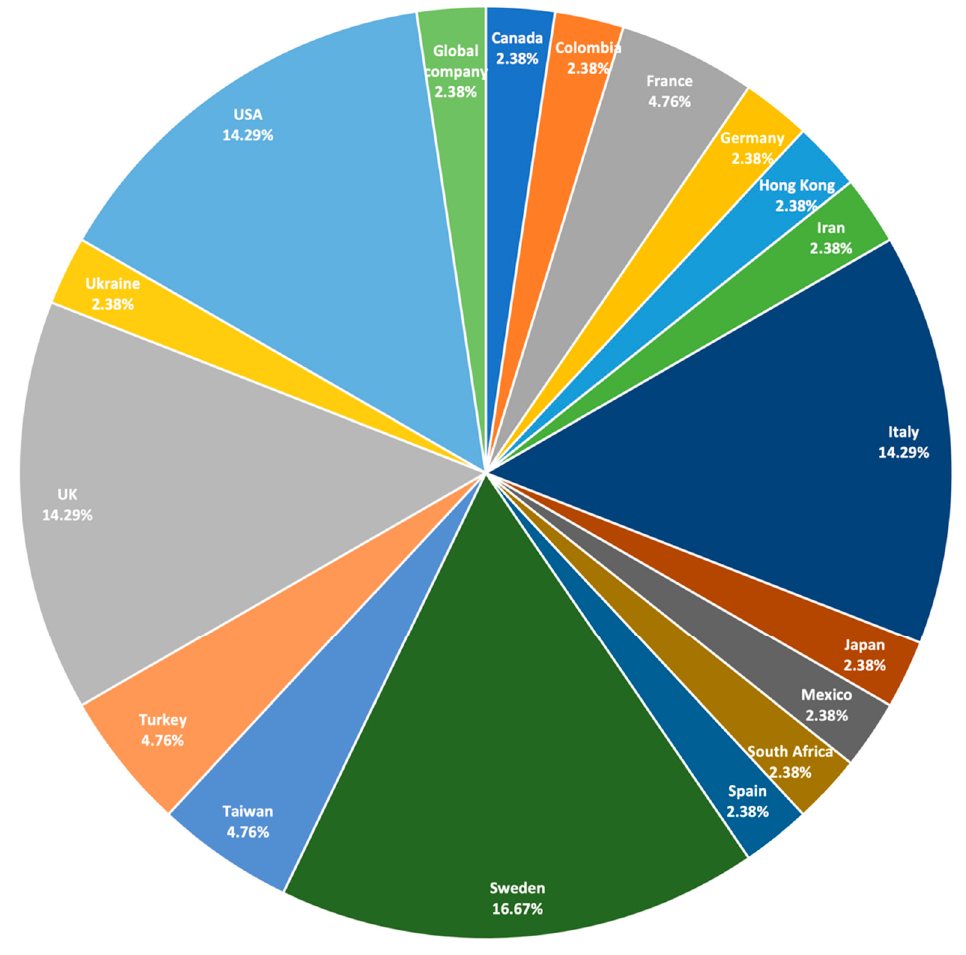
Figure 7. Implementing countries.